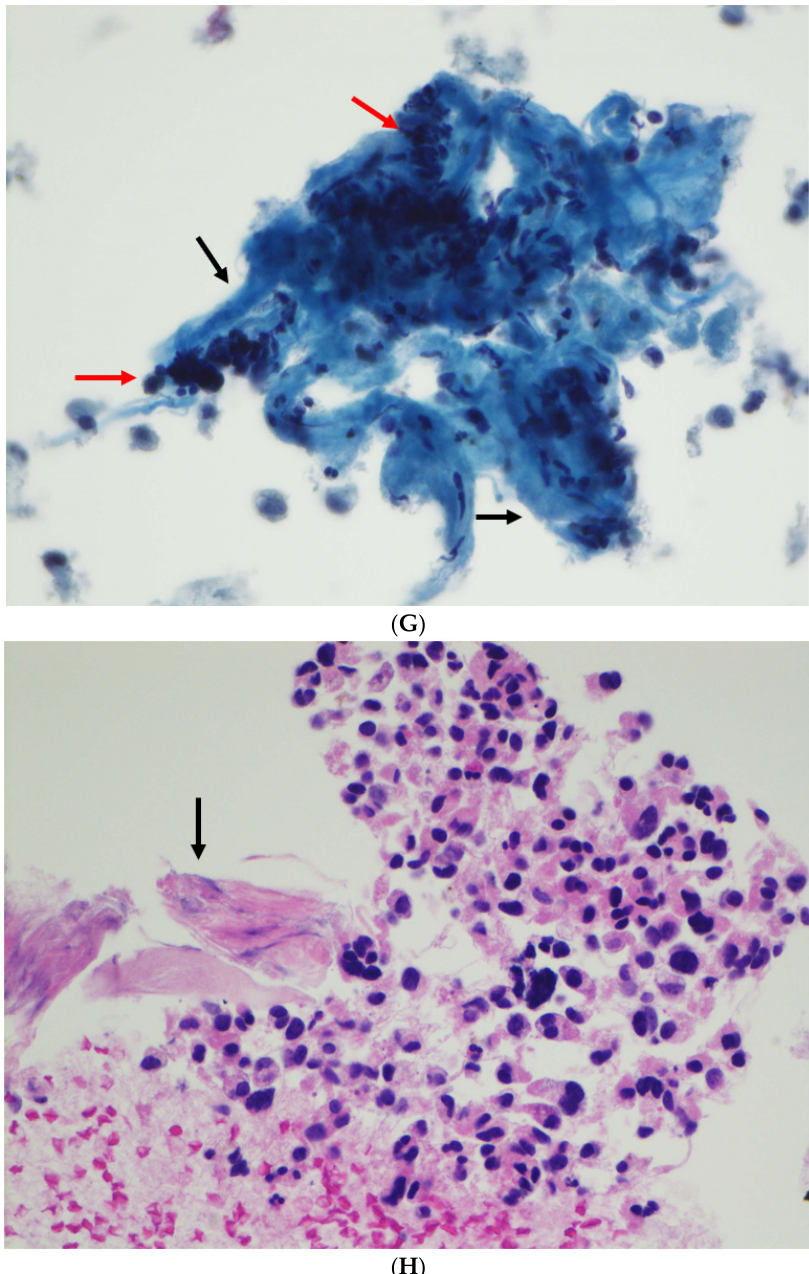
Figure 2. ( A ) Cholesterol crystals (Case #7, EUS-FNA, Diff-Quik, original magnification ×100). ( B ) Prominent clear cell changes (Case #9, EUS-FNA, Diff-Quik, original magnification ×400). ( C ) Prominent clear cell changes (Case #9, EUS-FNA, cell block, H&E, original magnification ×400). ( D ) Monomorphic neoplastic cells in contrast to large pleomorphic atypical multinucleated giant cells (black arrows) with a vacuolated cytoplasm (Case #12, EUS-FNA, Diff-Quik, original magnification ×400). ( E ) Pleomorphic atypical multinucleated giant cells (black arrows) with nuclear irregularity (Case #12, EUS-FNA, cell block, H&E, original magnification ×400). ( F ) Separate case showing atypical multinucleated giant cells (black arrows) (Case #14, EUS-FNA, Papanicolaou, original magnification ×200). ( G ) Hyalinized acellular stroma (black arrows) associated with atypical multinucleated giant cells (red arrows) (Case #14, EUS-FNA, Papanicolaou, original magnification ×200). ( H ) Hyperchromatic atypical multinucleated giant cells and acellular hyaline and myxoid fibrovascular stroma (black arrow) (Case #14, EUS-FNA, cell block, H&E, original magnification ×200).